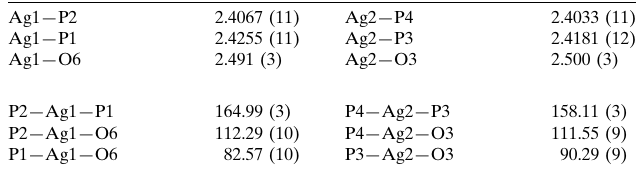
Selected geometric parameters (A˚ , (cid:2)